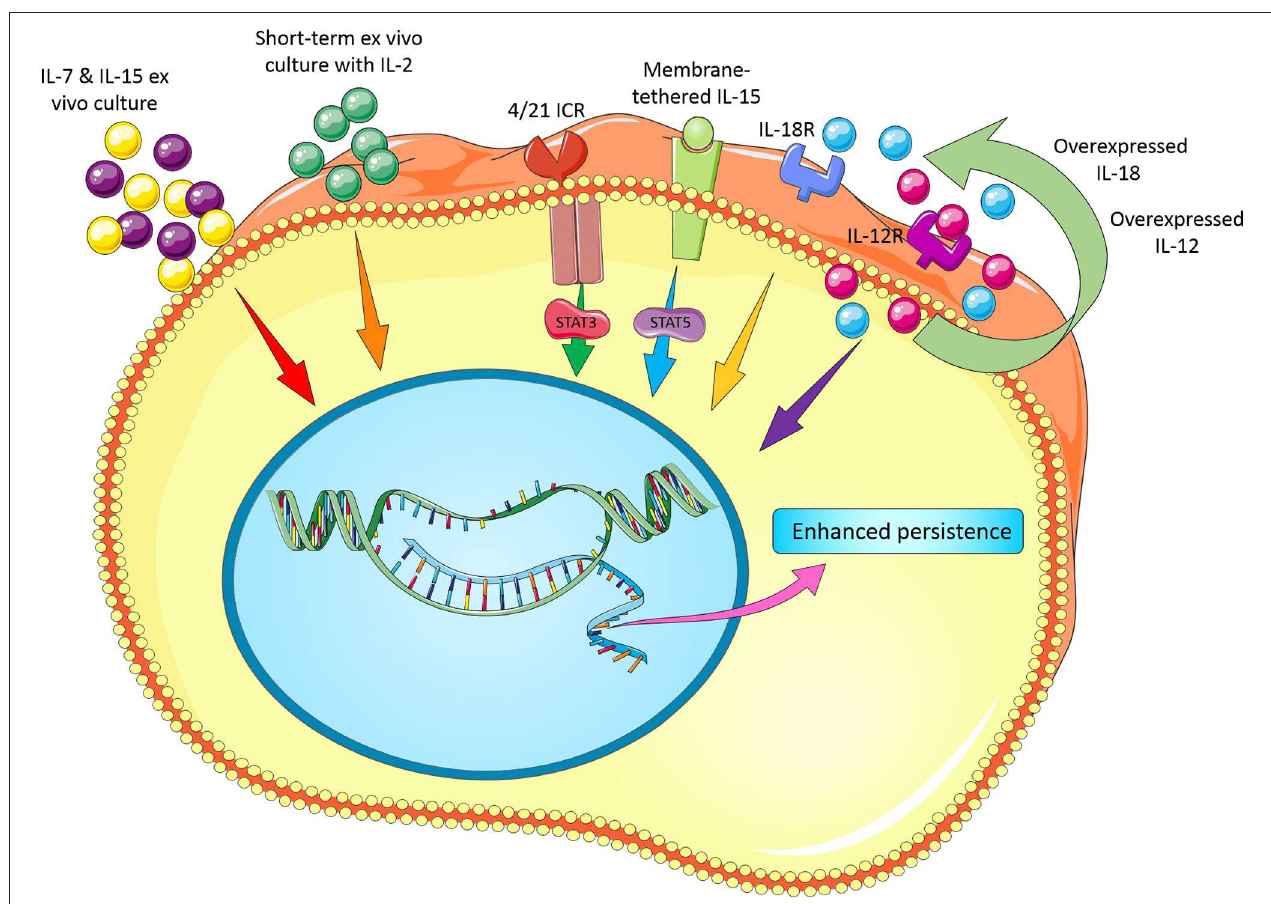
FIGURE 1 | Novel modifications in cytokine recipe and their receptors to enhance CAR T cell